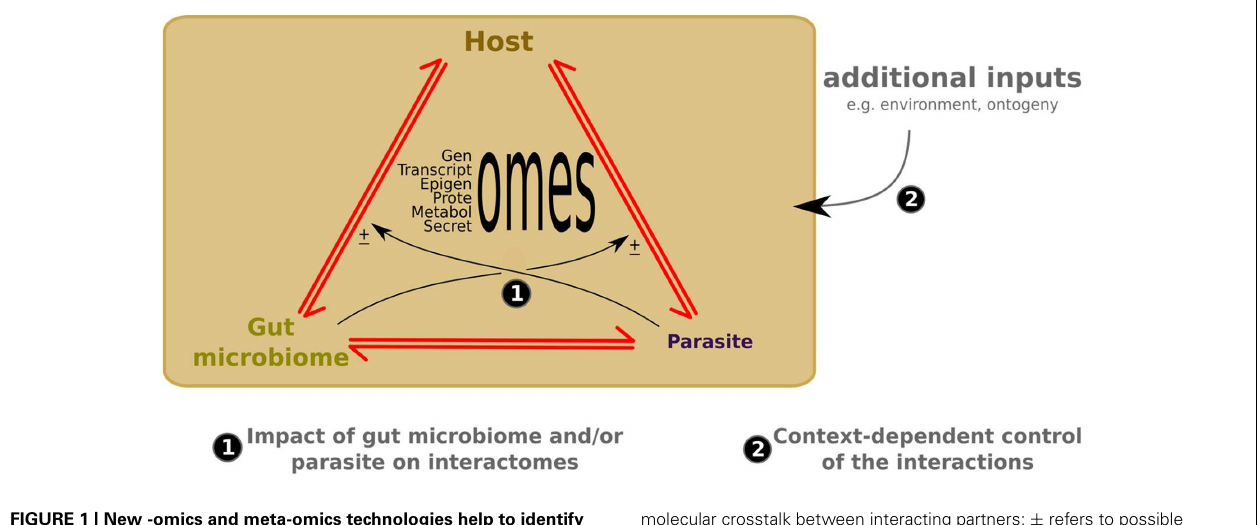
FIGURE 1 | New -omics and meta-omics technologies help to identify candidate molecular interactions in the three-partner crosstalk (1) and context-dependent control of the interactions (2). Red arrows indicate